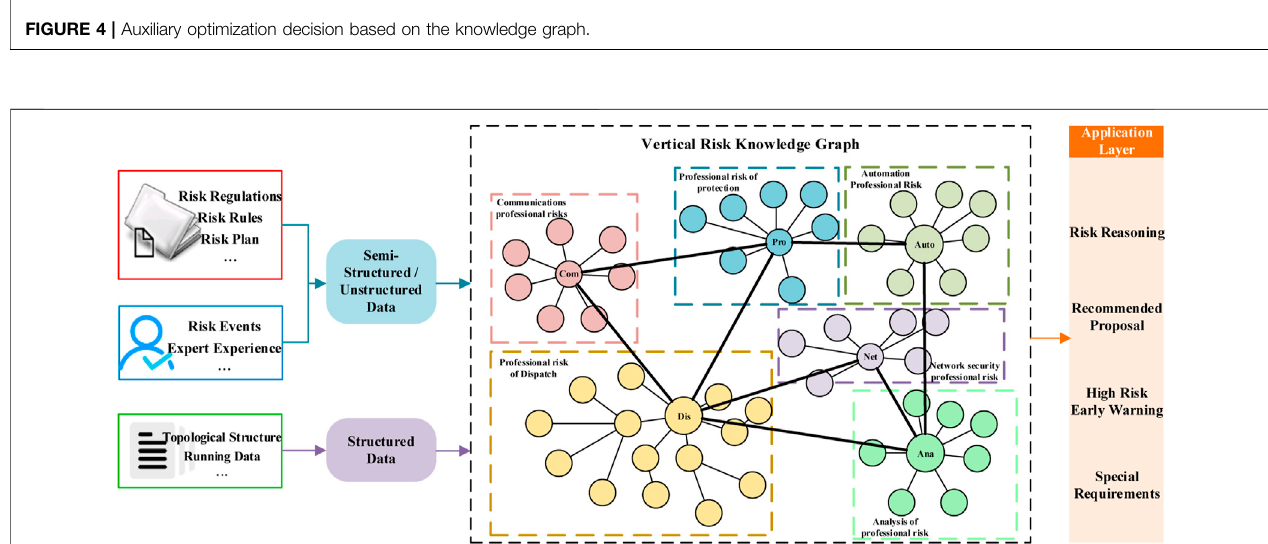
FIGURE 5 | Multiple coupling vertical risk schematic